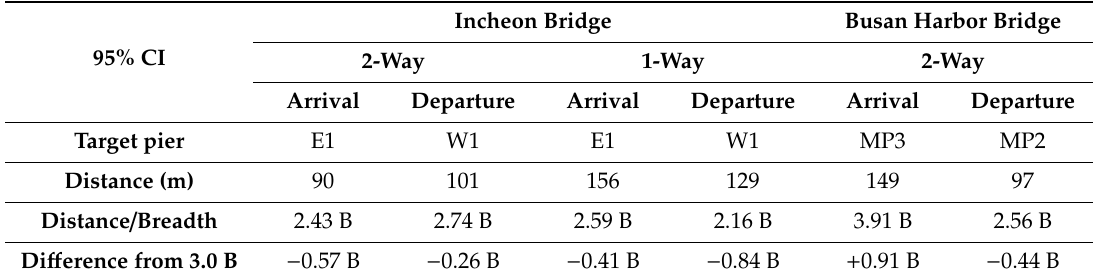
Table 17. Variation of distance di ff erence divided by the ship maximum breadth.